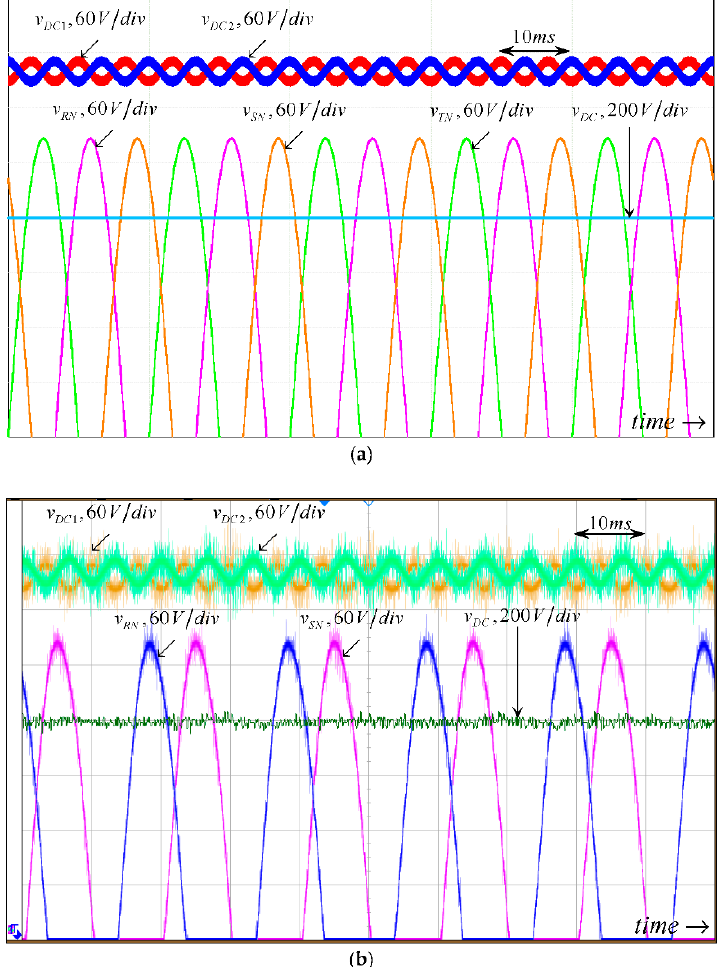
Figure 7. Results of capacitor low-frequency current rating imposed design. ( a ) Simulation. ( b ) Exper- iment.